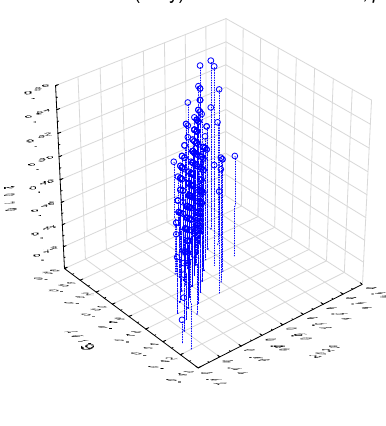
Figure 9. Differences in the space of the three-dimensional synthetic measure, waste management and green economy in communes of Eastern Poland in 2010–2020. Source: own study.